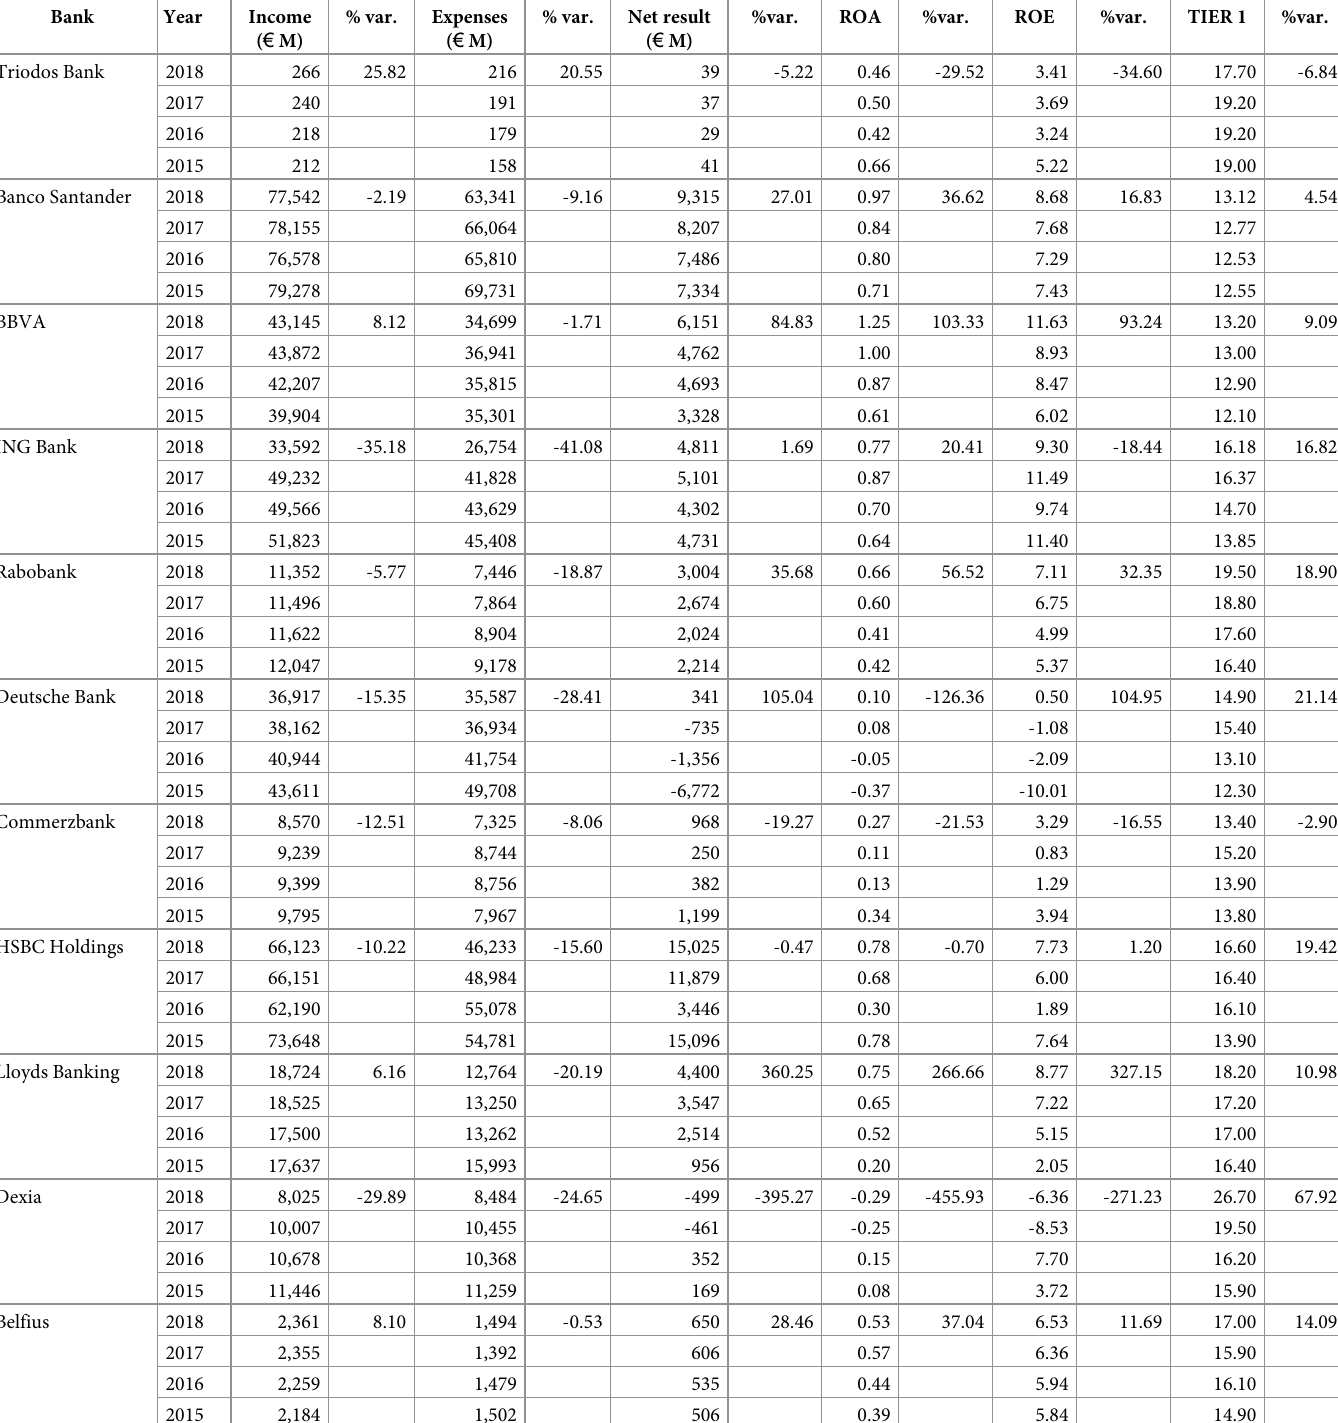
Table 7. Comparison of income, expenses, taxes and net result by year. Bank Year %var. TIER 1 %var. Triodos Bank